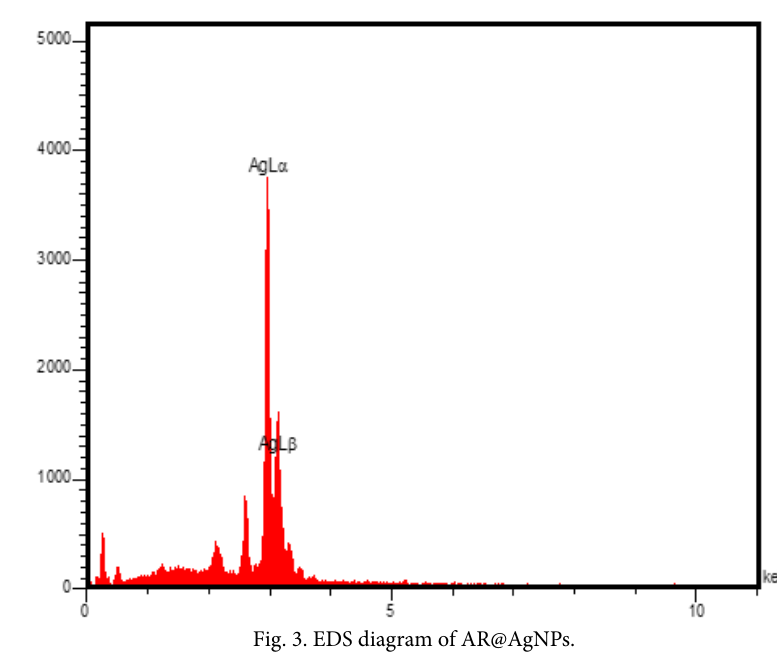
Fig. 3. EDS diagram of AR@AgNPs.